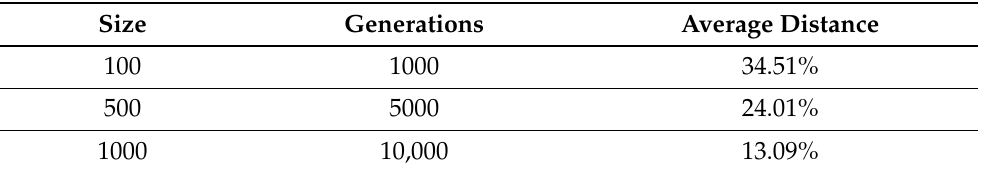
Table 7. Mutation domination experiment—averaged results from all instances, grouped by popula- tion sizes and iterations count.